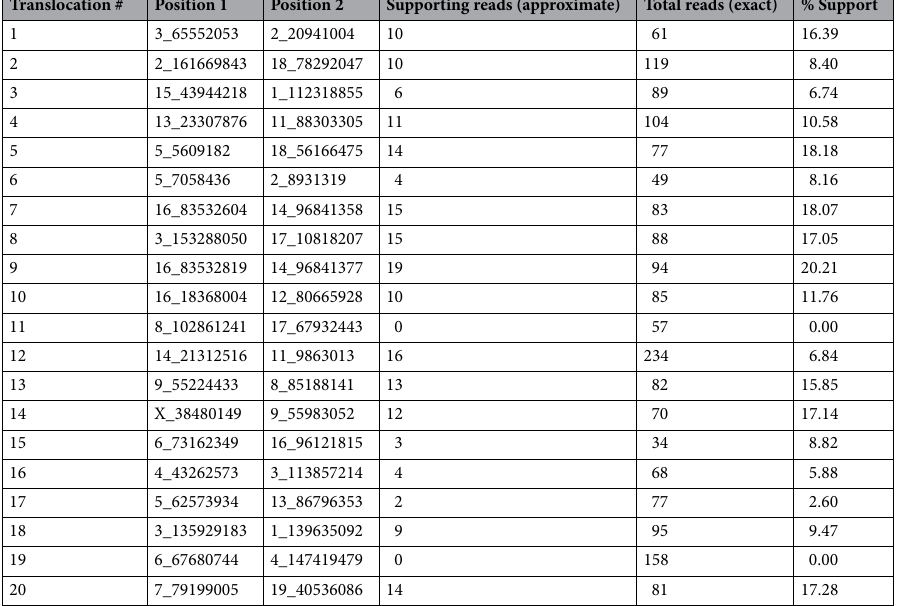
Table 1. Supporting reads for 20 randomly selected translocations from the tumor in Fig. 6. Random translocations were selected by inputting all translocations from the tumor into Excel, and using the RAND() function to assign a random number. The 20 highest translocations were then selected. Positions 1 and 2 represent the translocation breakpoint. Genome Ribbon was used to analyze read